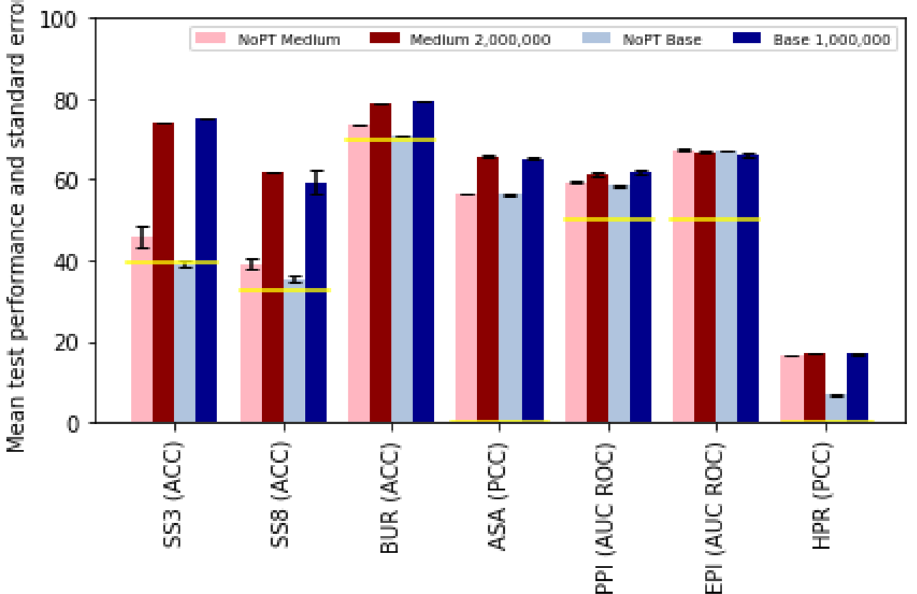
Figure 1. Improved performance on downstream tasks with pre-trained models. Prediction performances of the benchmark test set, as introduced in section ProteinGLUE Benchmark tasks , for a medium model without the pre-training step (pink), medium model including a pre-trained model until step 2 000 000 (dark red), base model without the pre-training step (grey), and base model including a pre-trained model until step 1 000 000 (dark blue). The yellow lines indicate the performance of a random or majority-class baseline. All models are trained ten times on their selected set of hyperparameters after which the mean performance and standard error is determined.